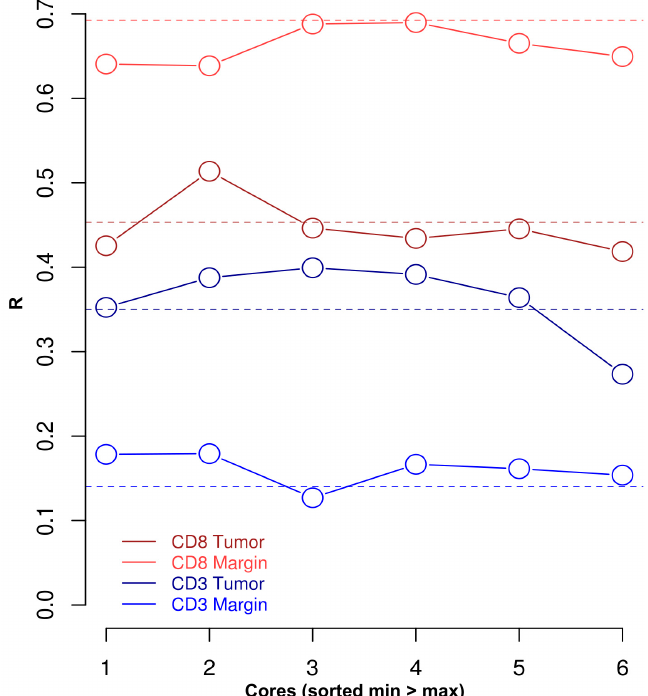
Figure 5. Correlation of the mean T cell densities of 6 cores with mean T cell densities of full tissue sections (dashed line) versus ascending sorted mean T cell densities of 1–6 cores. Strength of correlation between T cell densities on full tissue sections and virtual TMA does not depend on the mean T cell density of the cores chosen for correlation. From bottom to top: Tumoral CD3 – low T cell density core, R = 0.35 vs. high density core, R s = 0.26 (moderate correlation), max. core 3, R = 0.40; marginal CD3 – low T cell density core, R = 0.18 vs. high density core, R = 0.17 (weak correlation), max. core 2, R = 0.19; tumoral CD8 – low T cell density core, R = 0.42 vs. high density core, R = 0.40 (moderate correlation), max. core 2, R = 0.51; marginal CD8 - low T cell density core, R = 0.64 vs. high density core, R = 0.66 (strong correlation); max. core 4, R = 0.70. Note. R—Spearman's correlation coefficient.